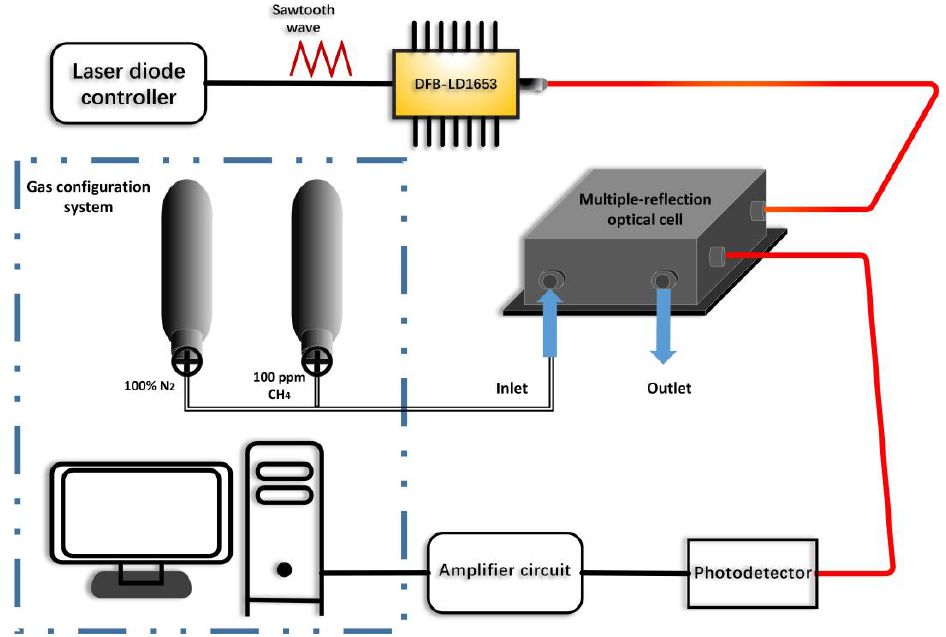
Figure 2. Schematic of the CH 4 detection system.